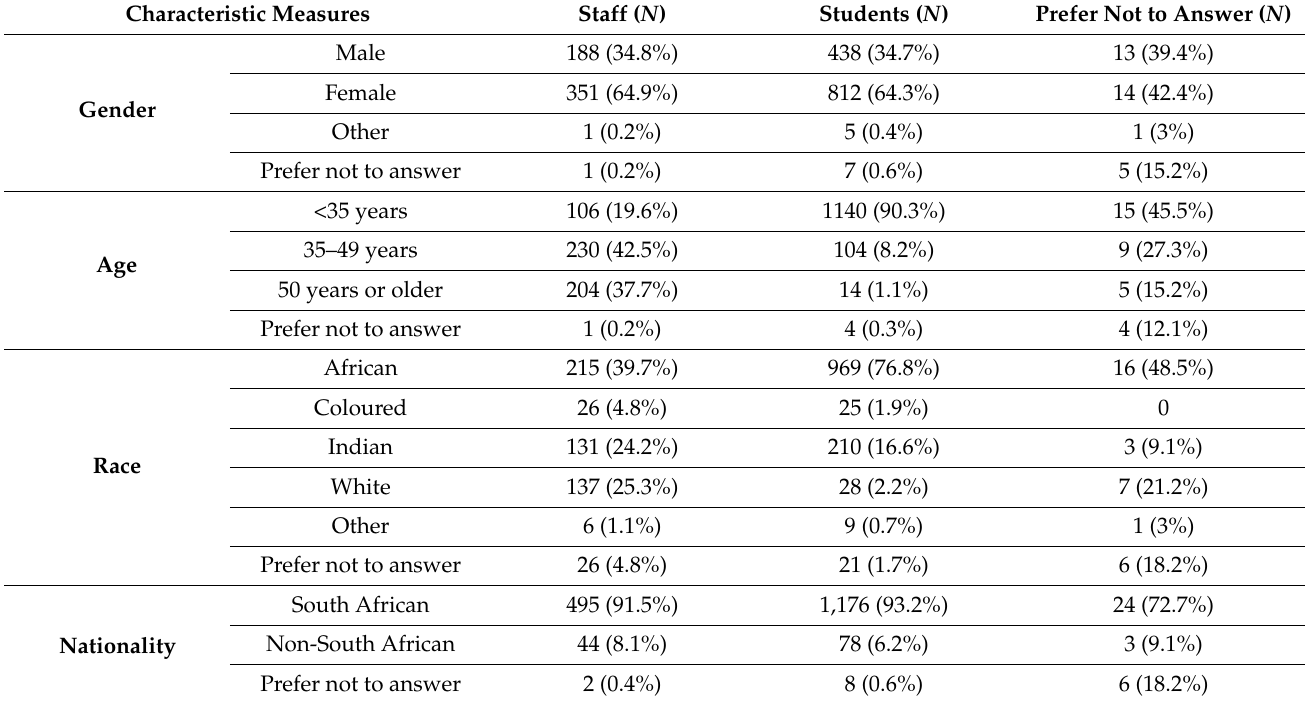
Table 2. Sociodemographic characteristics of respondents by UKZN association.